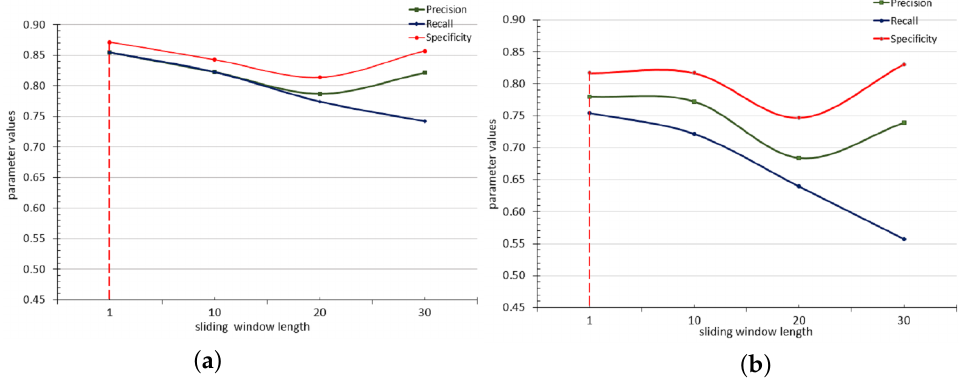
Figure 6. Line charts showing precision, recall and specificity against different sliding window length, ( a ) half hour prediction horizon; ( b ) one hour prediction